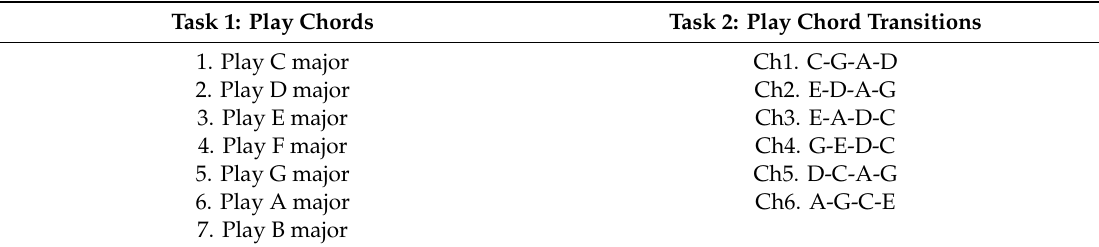
Table 1. Proposed learning